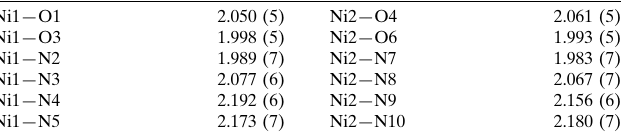
Selected bond lengths (A˚ ).